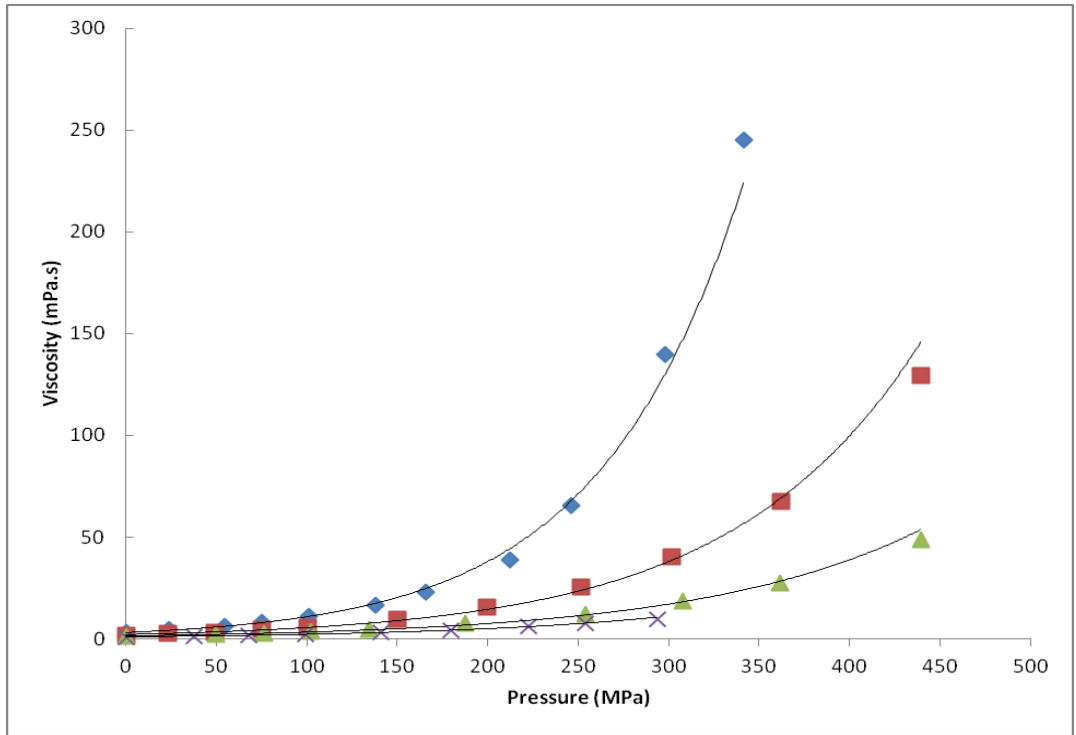
Figure 4. Variation of viscosity for Fuel 2 with temperature. ♦ 298 K, ■ 323 K, ▲ 348 K, and X 373 K.